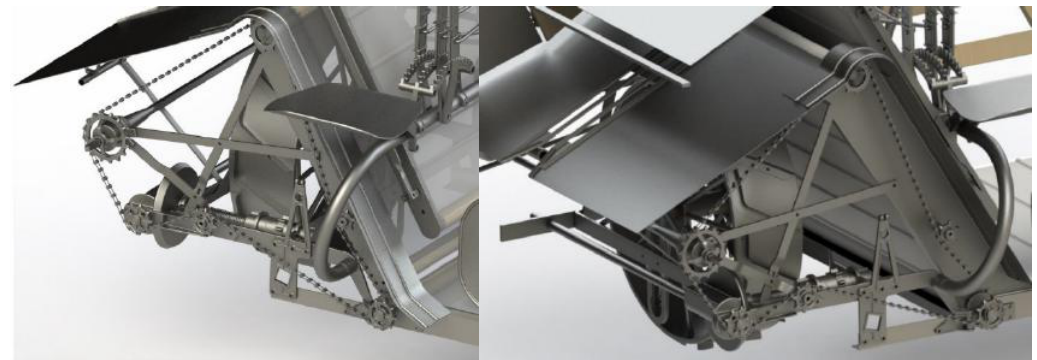
Figure 25. Mechanical transmissions: back view ( left ) and front view ( right ).